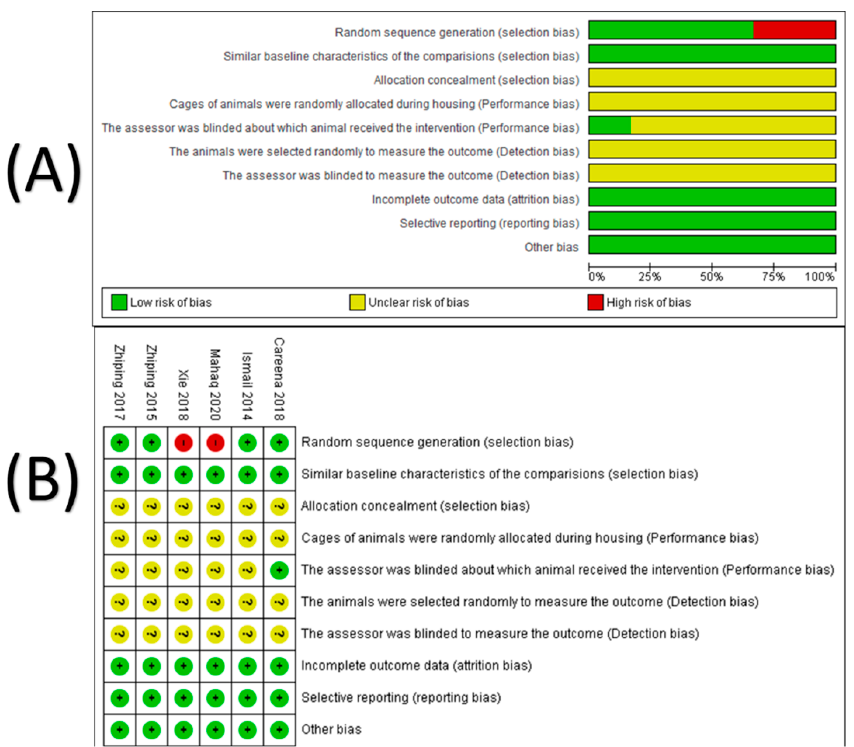
Figure 2. Assessment of risk of bias; ( A ): risk of bias across the included studies, ( B ): risk of bias within each study. Green color indicated a low risk of bias, Yellow color indicated unclear risk of bias, red color indicated high risk of bias. Careena et al., 2018: [20], Ismail 2014: [22], Mahaq 2020: [26], Xie 2018: [18], Zhiping 2015: [25], Zhiping 2017: